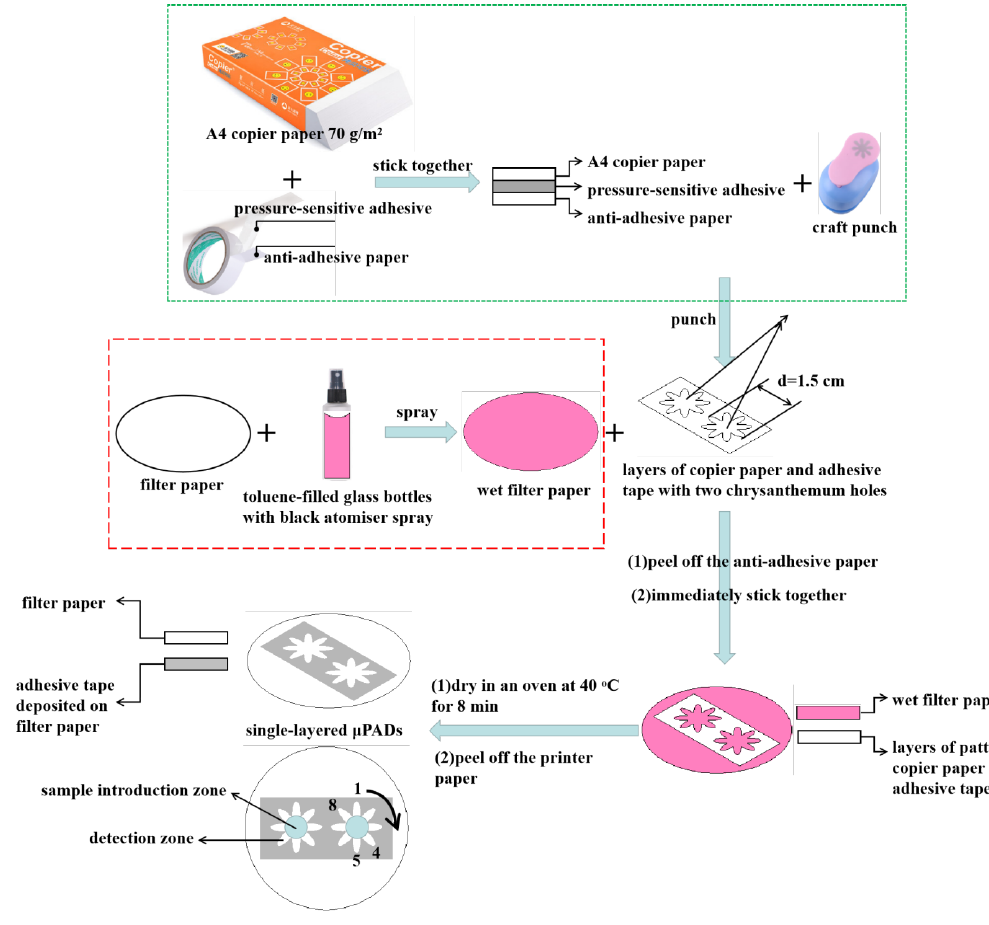
Figure 1. Schematic illustration of the fabrication process of single-layered single-layered paper-based microfluidic devices